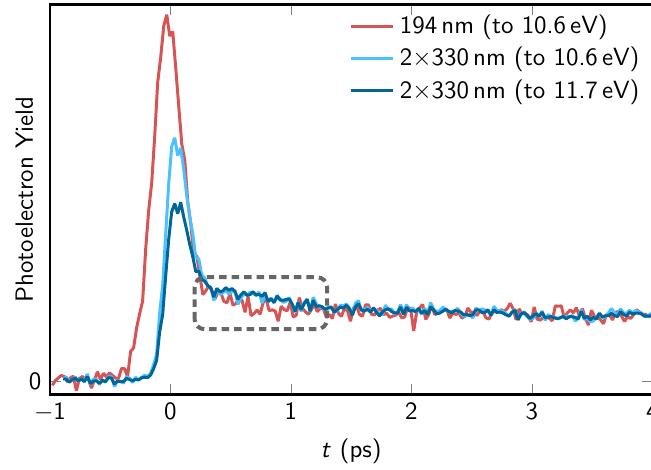
Figure 2. Time traces showing the total photoelectron yield as a function of pump-probe delay, t (ps). The TRPE spectra recorded at 293 nm + 194 nm (red) and 292 nm + 2 330 nm (light blue) were × integrated over all electron binding energies E b 10.6 eV. The TRPE spectrum at 292 nm + 2 330 nm ≤ × was also integrated for E b 11.7 eV (plotted in dark blue), i.e., over the entire range observable with ≤ the available (1 + 2’) total photon energy. All time traces are scaled so that their photoelectron yields match at long pump-probe delays in the 3–4 ps range. The grey box indicates the region where one- and two-photon experiments differ